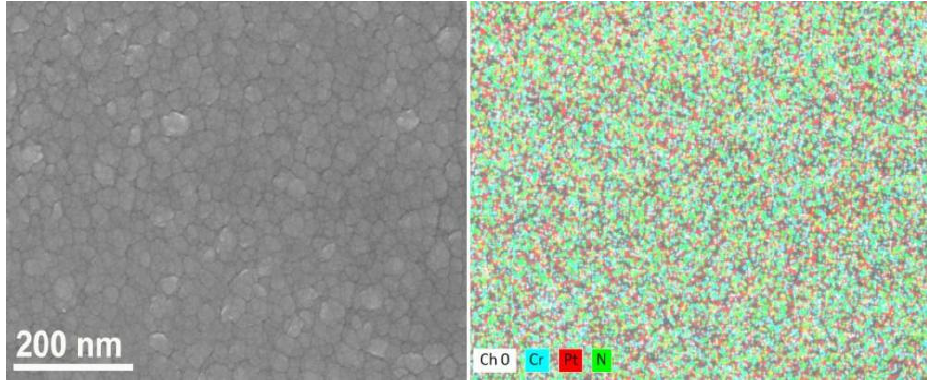
Figure 1. SEM image with corresponding element mapping of the CrN – Pt coating.